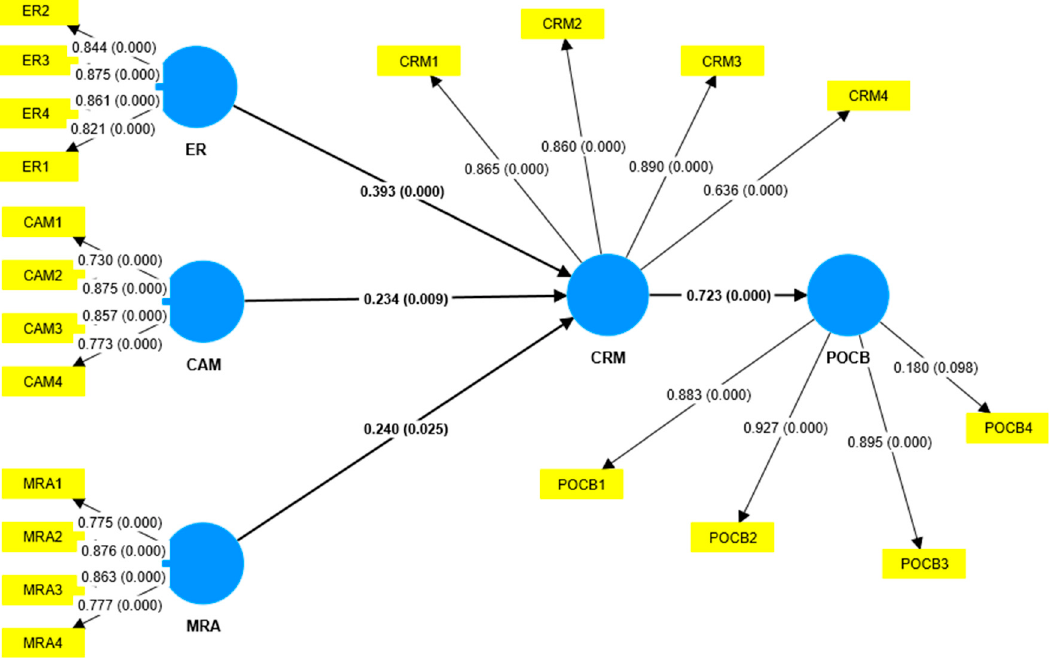
Figure 2. Structural equation modeling.